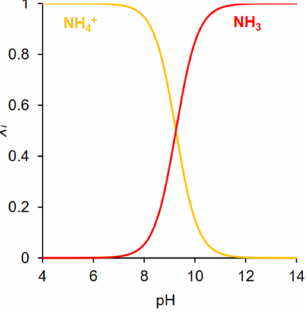
Figure 2. The molar fraction of NH 4 + ions and unionized NH 3 as a function of pH. Adapted from Ref. [39] Copyright 2022,